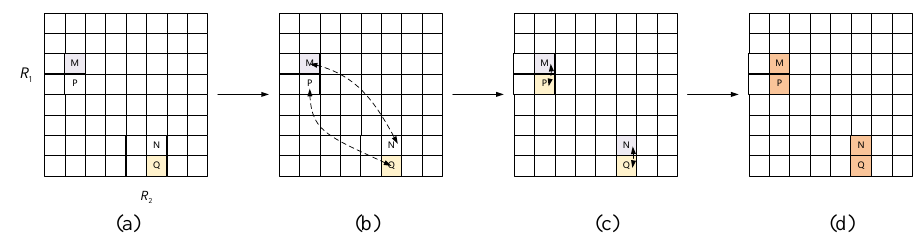
Figure 4. The information propagation process of the proposed SPAM. ( a ) M and P are the two pixels in region R 1 ; and N and Q are the two pixels in region R 2 . ( b ) During the first PAM operation, the information is transmitted between M and N and between P and Q, respectively. ( c ) During the second PAM operation, the information is transmitted between M and P and between N and Q, respectively. ( d ) M, N, P, and Q contain global and local